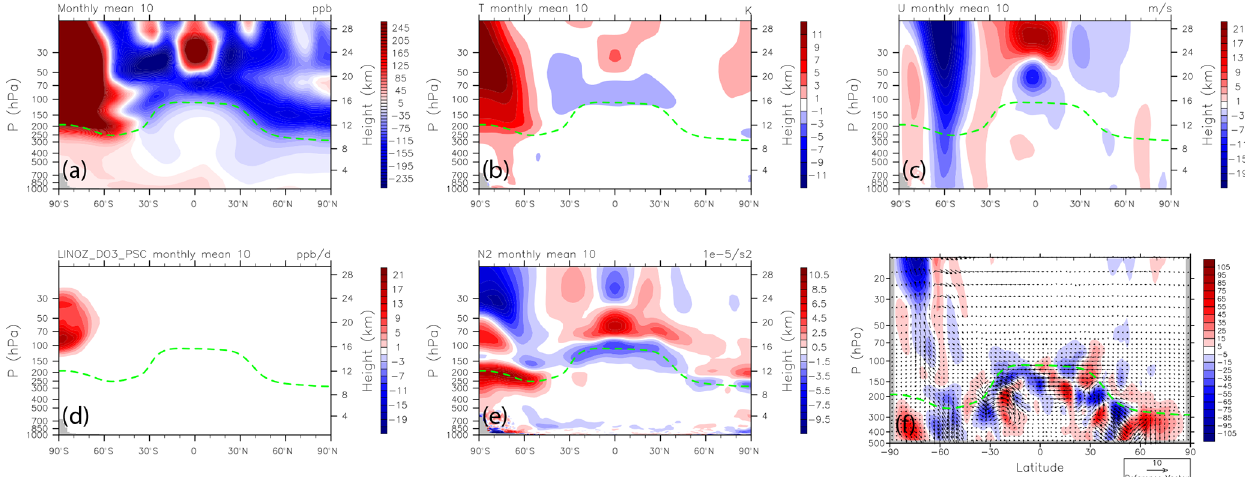
Figure A2. Pressure (10–1000hPa) by latitude (90 ◦ S–90 ◦ N) October mean differences between the untuned O3v2 and O3v1 for (a) O 3 , (b) temperature, (c) zonal wind, (d) PSC ozone loss tendency, (e) buoyancy frequency squared (N 2 ), and (f) E–P flux vector and